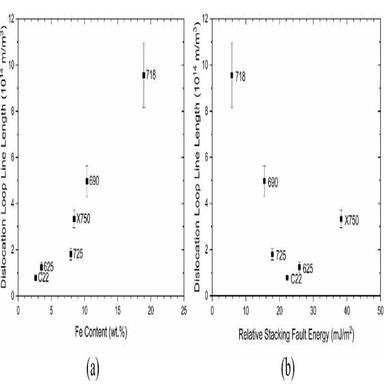
Irradiation-induced dislocation loop line length in the Ni-base alloys as a function of (a) Fe content, and (b) stacking fault energy (SFE) relative to pure Ni (~130 mJ/m2 ).